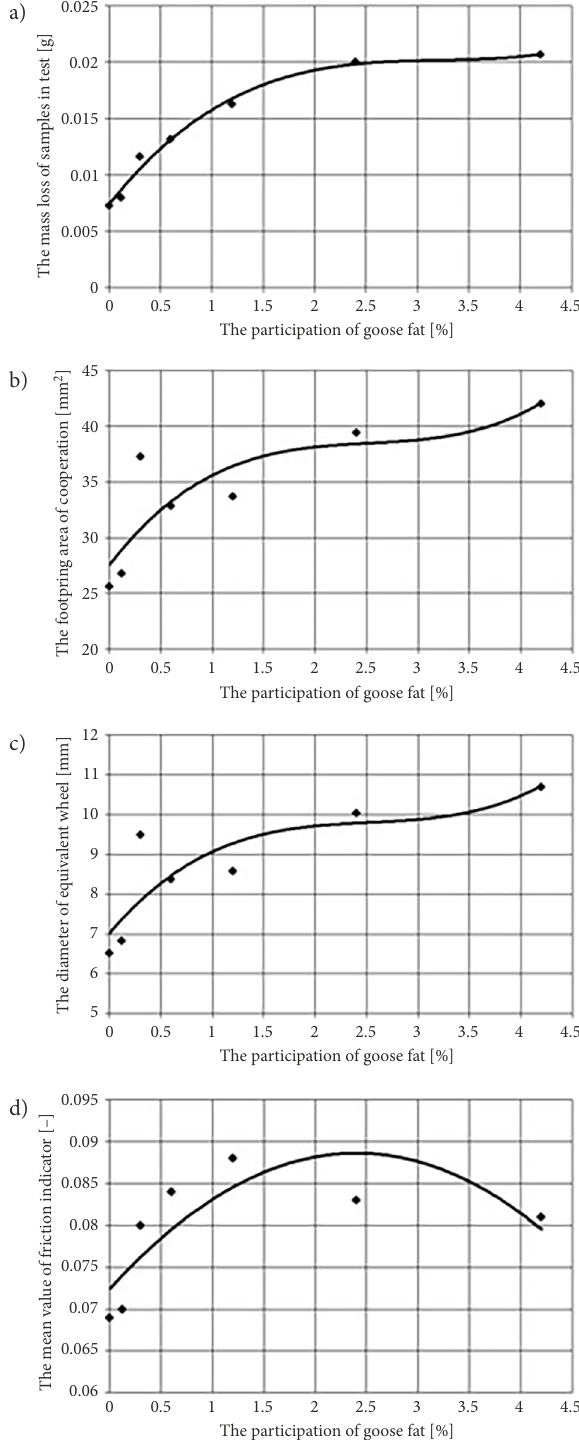
Figure 3. The results of the lubricants features of RME with goose fat: a – mass loss of samples; b – the footprint area of cooperation; c – the diameter of an equivalent wheel; d – the average value of coefficient of